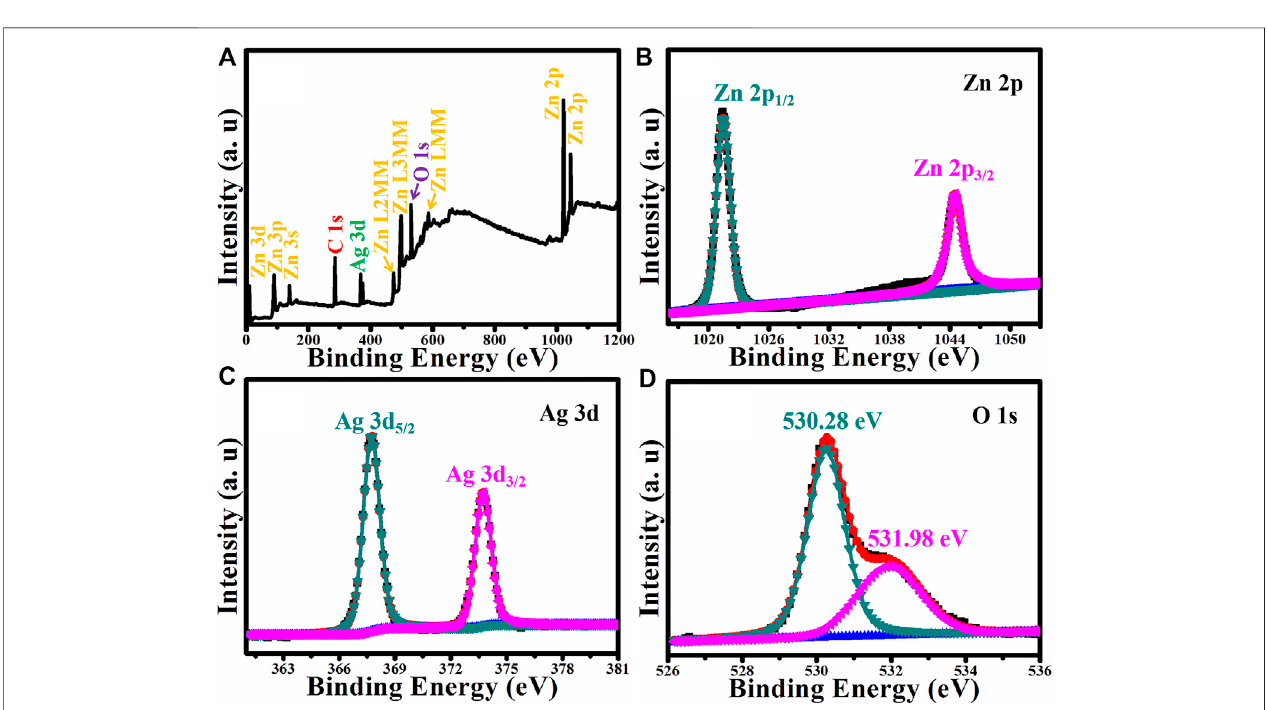
FIGURE 7 | (A) XPS survey spectrum of Ag/ZnO and the corresponding high resolution XPS spectra of (B) Zn 2p, (C) Ag 3d, and (D) O 1s.